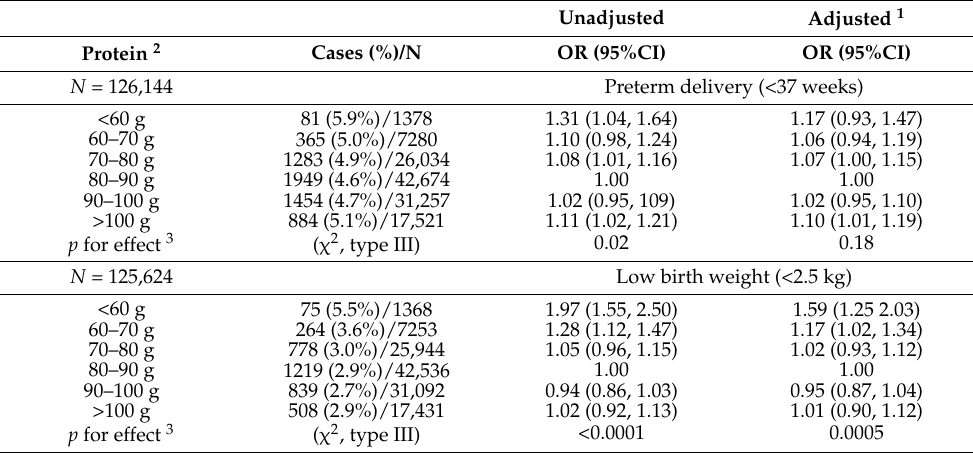
1 Adjusted for cohort, age, parity, maternal smoking, pre-pregnancy body mass index, height, education, marital status, infant sex and total energy intake. 2 Across categories from low (<60 g) to high (>100 g) protein intakes, the corresponding median (10th–90th percentiles) protein intake relative to body weight (in g/kg) was 0.9 (0.6–1.1), 1.0 (0.8–1.3), 1.2 (0.9–1.4), 1.3 (1.0–1.6), 1.4 (1.1–1.7) and 1.6 (1.2–2.0), respectively. 3 F test type